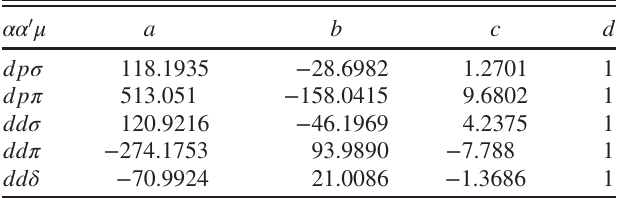
TABLE IV. The values of the fitting